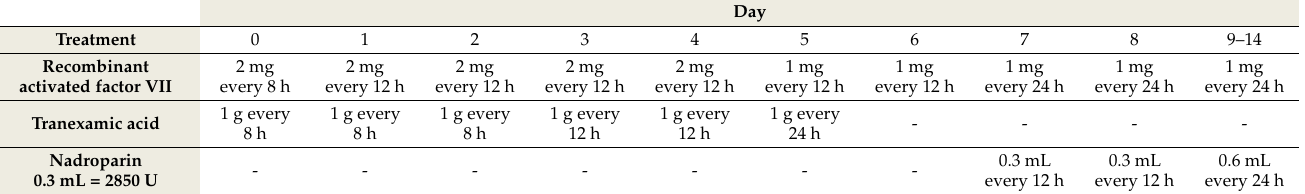
Table 1. Dosage of recombinant activated factor VII, tranexamic acid, and nadroparin after delivery on days 1–14.